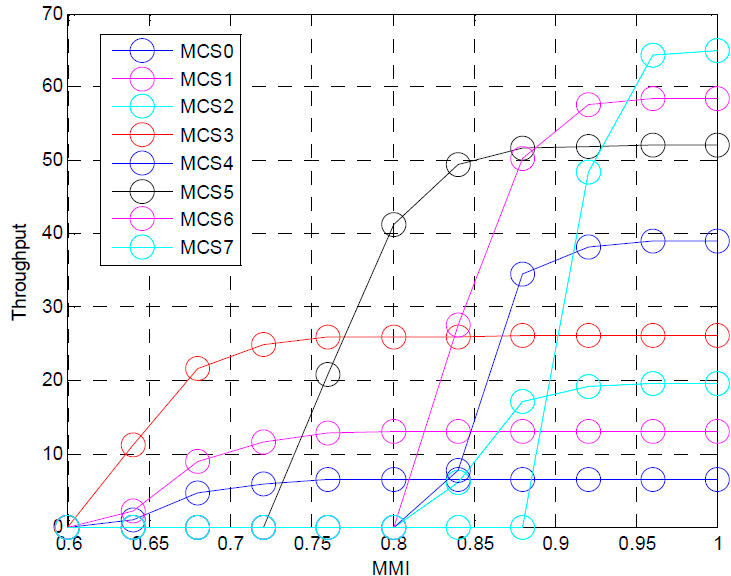
Figure 12. MMI-to-throughput tables for modulation schemes.